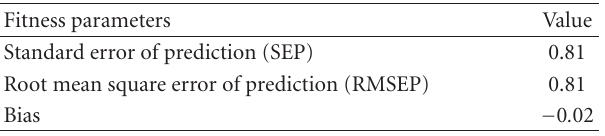
Table 3: Total kernel ratio predicted by the model. Peanut